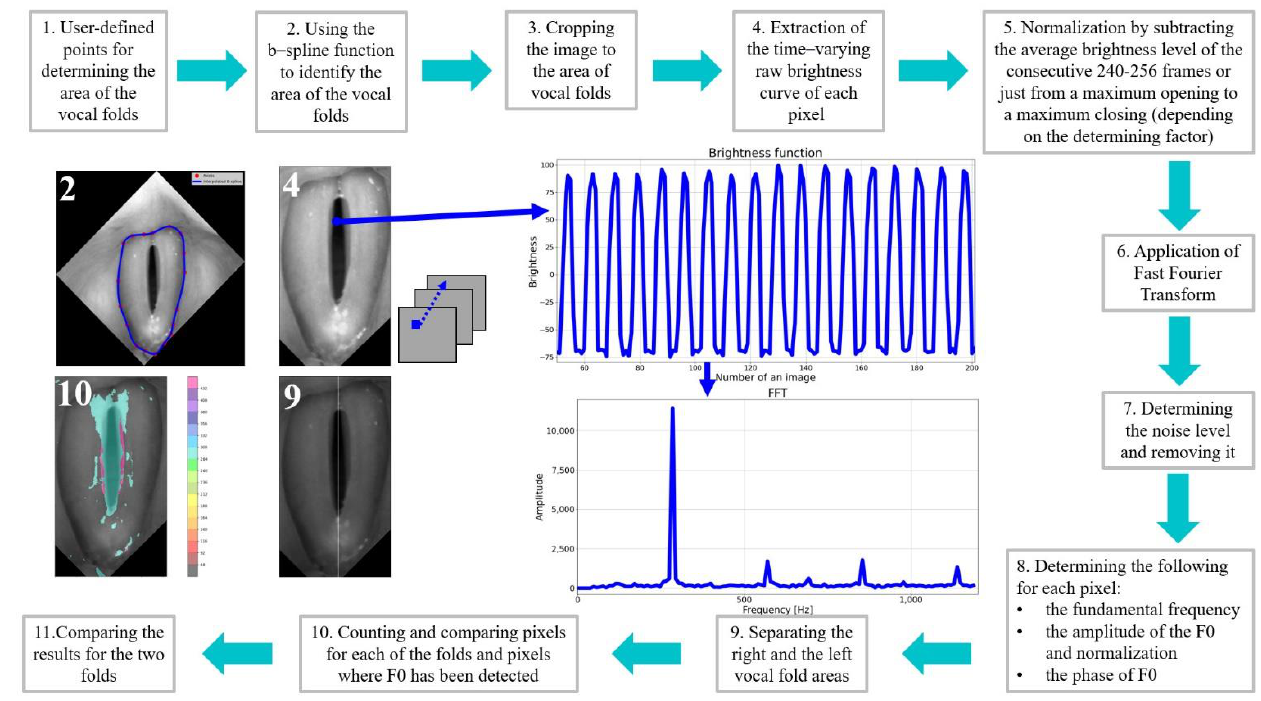
Figure 2. Sequence of procedures for processing and analysis of LHSV recordings.